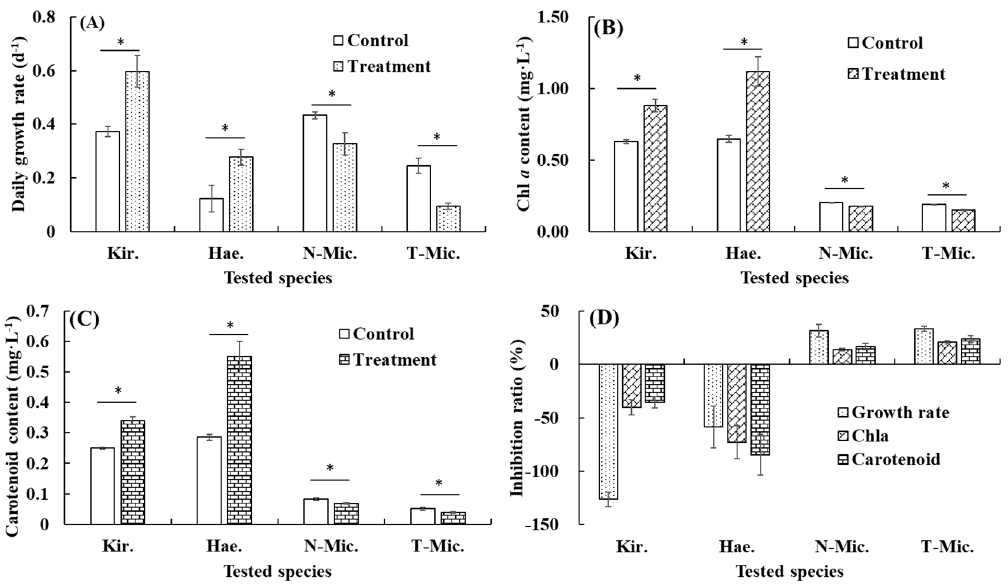
Figure 2. Effects of water extracts from D. indicum flowers at 1.0 g·DW·L − 1 on daily growth rate ( A ), chlorophyll a content ( B ), and carotenoid content ( C ) of Kirchneriella sp. (Kir.), H. pluvialis (Hae.), and non-toxigenic (N-Mic.) and toxigenic M. aeruginosa (T-Mic.), and the inhibition ratios according to the three parameters ( D ) during 3-day bioassays. * indicates significant differences between the control and the treatment at p < 0.05 level.